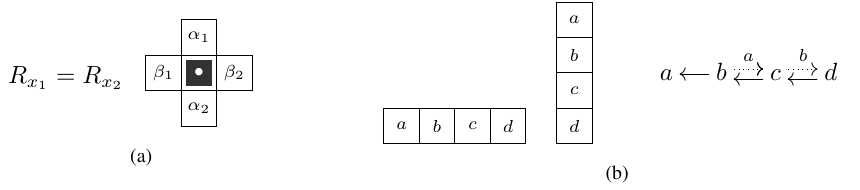
Figure 15: (a) A (2 , 4) priority strategy for the breaker for P 4 , 1 (b) Dependency digraph of the cells in the orientations of P 4 , 1 .